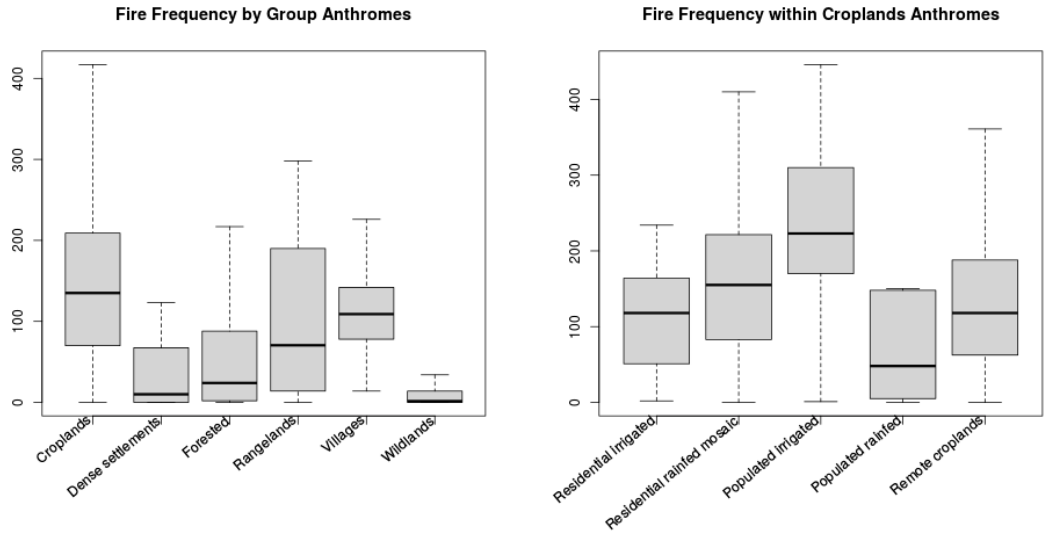
Figure 7. Between group comparison: Fire frequency by anthrome groups boxplots ( left ). Within group comparison: Fire frequency boxplots within cropland anthrome ( right ). Table 3. Between-anthromes Tukey pairwise comparison for the negative binomial models with fire count and anthromes groups. Note that the reference variable is in italic.